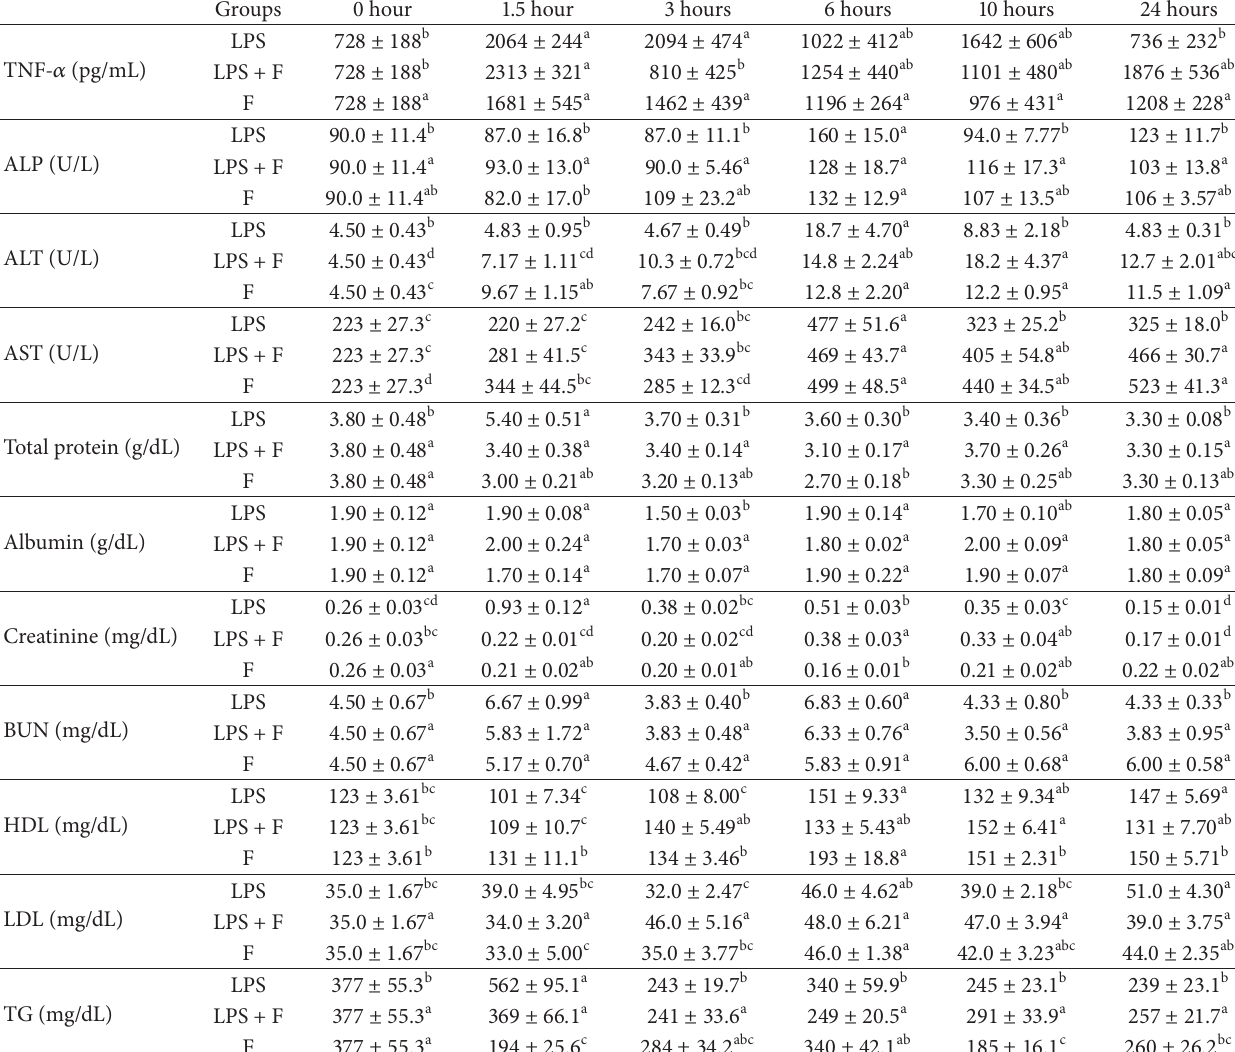
Table 1: The effect of florfenicol (F) on sTNF- 𝛼 and serum biochemical indices in endotoxemic fish (mean ± SE).